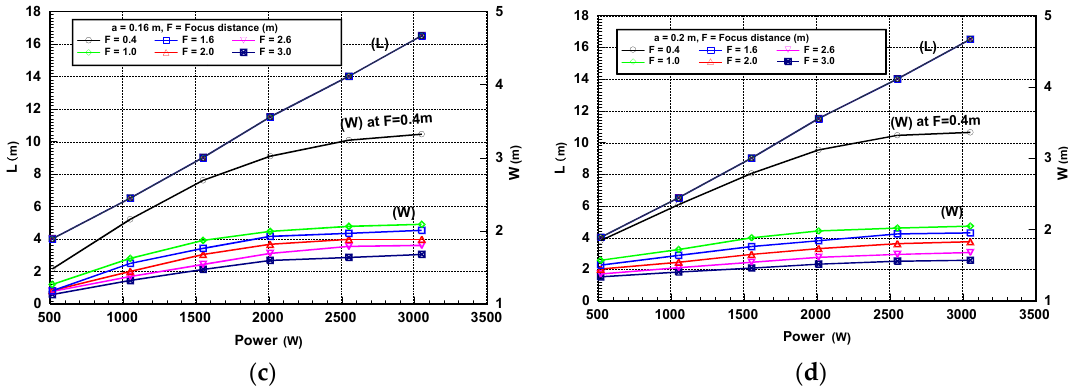
Figure 13. The length and the width of CPVT collector plotted against the required power with different focus distances, ( a – d ) different receiver width.